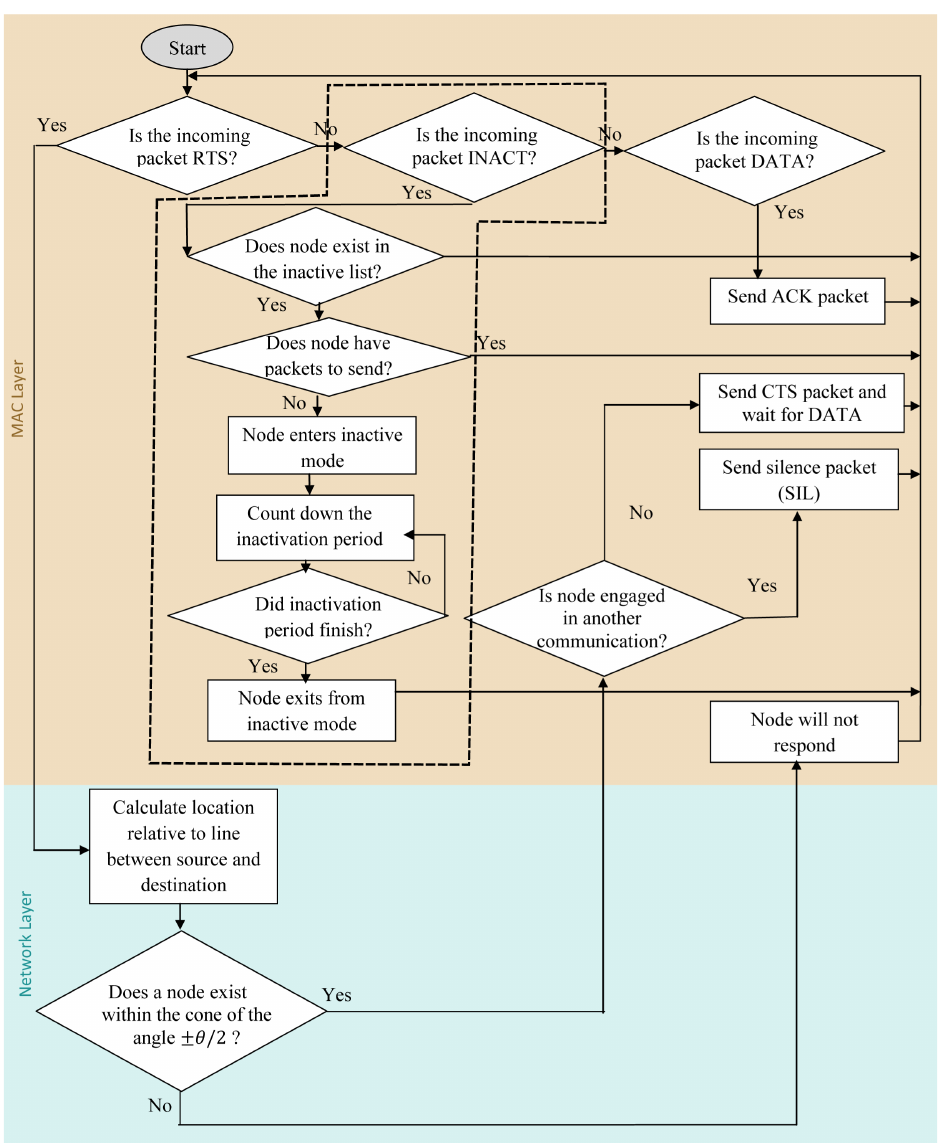
Figure 4. Flow chart of the proposed protocol from receiver